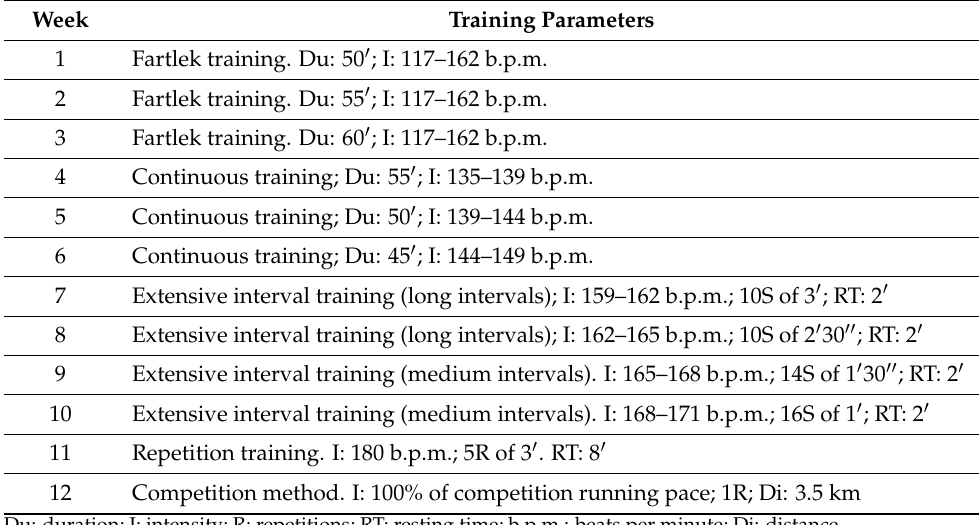
Table 2. Training methodology that will be used with